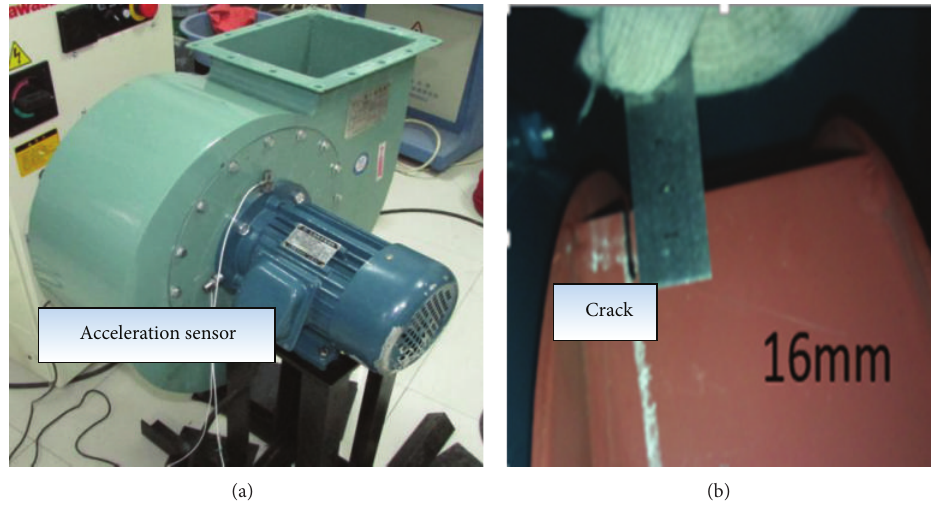
Figure 4: (a) Sensor installation position and (b) centrifugal fan with cracked blade.